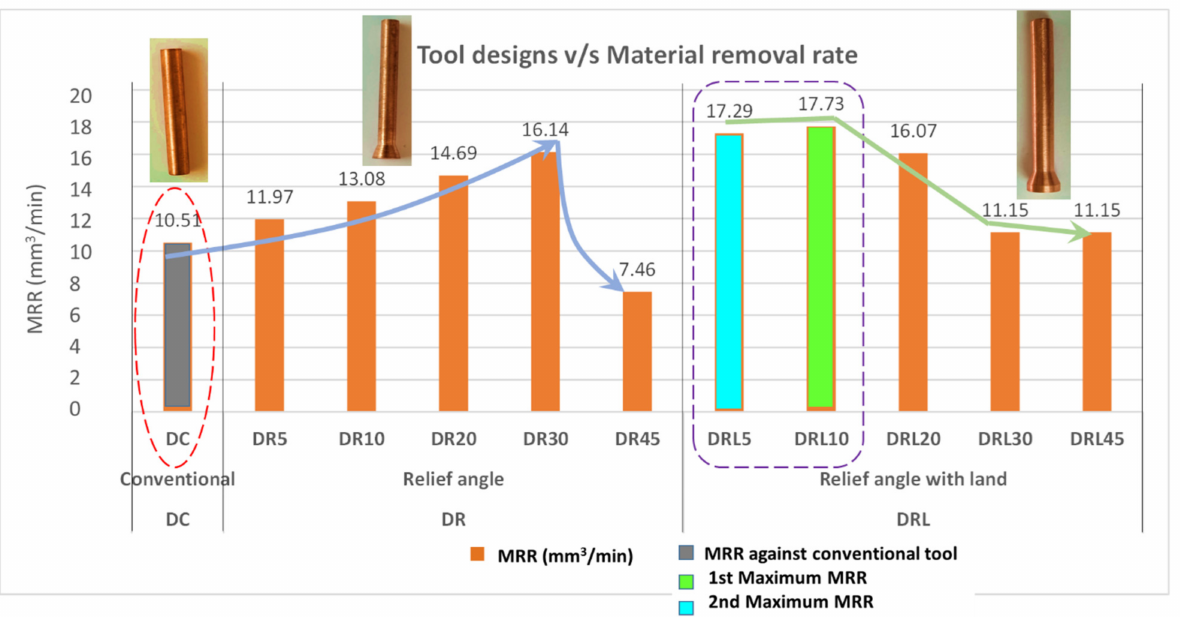
Figure 9. Comparison of material removal rate (MRR) under the use of different electrode